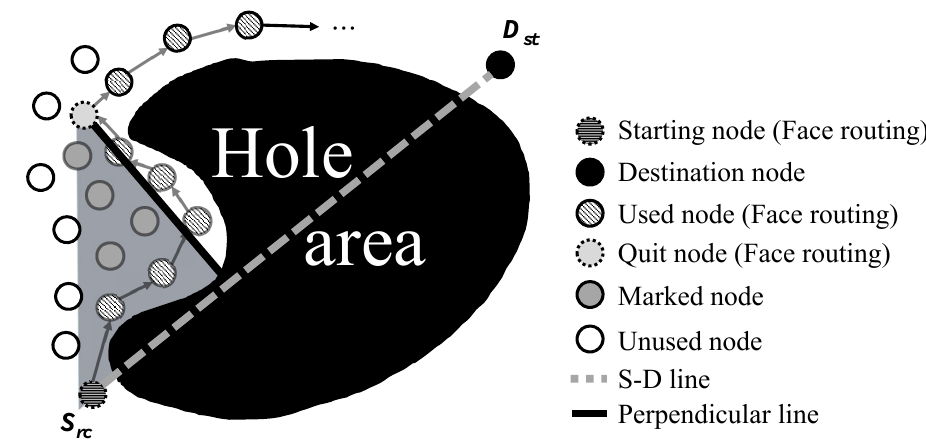
Figure 7. Marking process in an isosceles triangle area near a hole area. After that, the proposed scheme can identify the coordinates of a perpendicular line foot using an orthogonal formula using two straight lines. Using straight-line Equation (1) between the source and destination node as mentioned above, the proposed scheme can identify the first straight line to be used in orthogonal formula between two straight